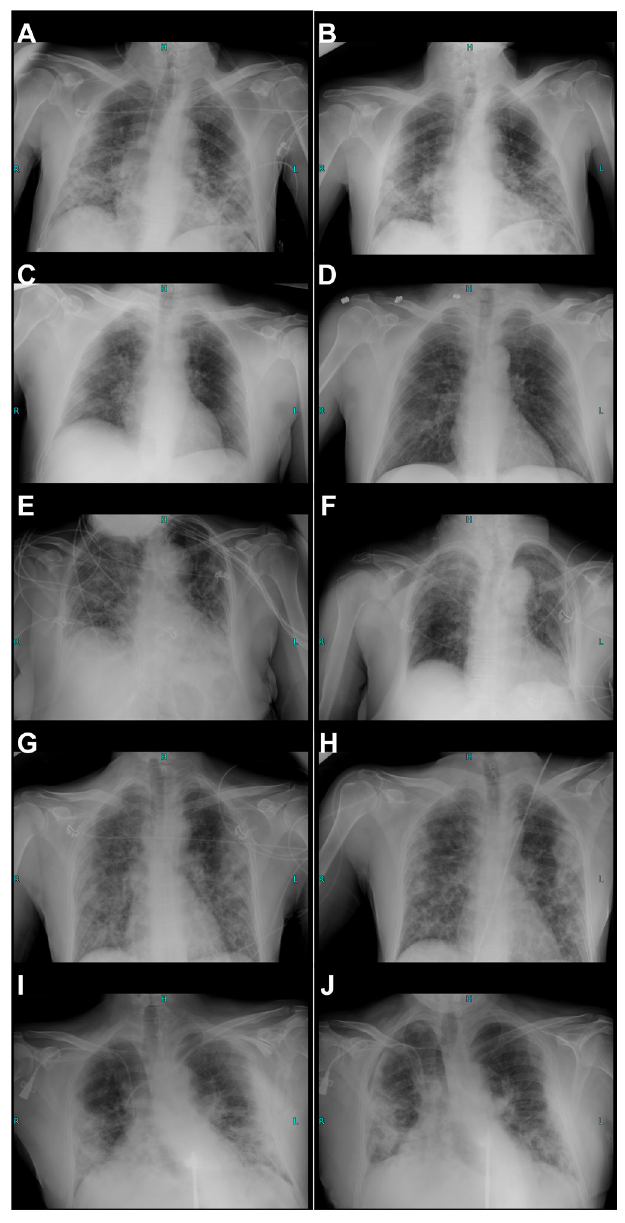
(Figure 6I) with SpO2 of 85%, dyspnoea, tachypnoea, and COVID-19 pneumonia; we observed bilateral reticulonodular areas of opacifications with perihilar and peripheral distribution, with consolidation in the upper right lung and evidence of right pleural effusion. Her condition was complicated because of Klebsiella pneumoniae, Streptococcus beta haemolyticus co-infection in respiratory samples, and vancomycin- resistant Enterococcus in urine samples taken within 24 after admission. At discharge, we observed minimal regressions in findings of consolidation and resolution of the right pleural effusion (F). Panel (G) shows the first X-ray image taken of a 51-year-old male (Figure 6J); chest X-ray findings point to bilateral perihilar and peripheral extensive patchy opacifications and a prominent zone of consolidation in the mid- and upper peripheral section, the left lobe was more affected. (H) Treatment resulted in the normalisation of peripheral oxygen saturation values. Still, X-ray images suggested a minor progression of initial findings; non-resolving bilateral consolidations with bigger consolidation zone in the left upper peripheral lung. Panel (I) shows patchy bilateral consolidations, perihilar and peripheral distribution, of a 50-year-old male (Figure 6B) admitted with a SpO2 of 92% and previous episodes of high body temperature. He received two cycles of oXiris® blood purification and